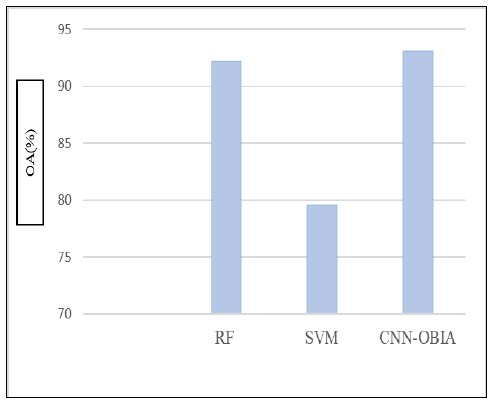
Figure 6 : Overall accuracy comparison of